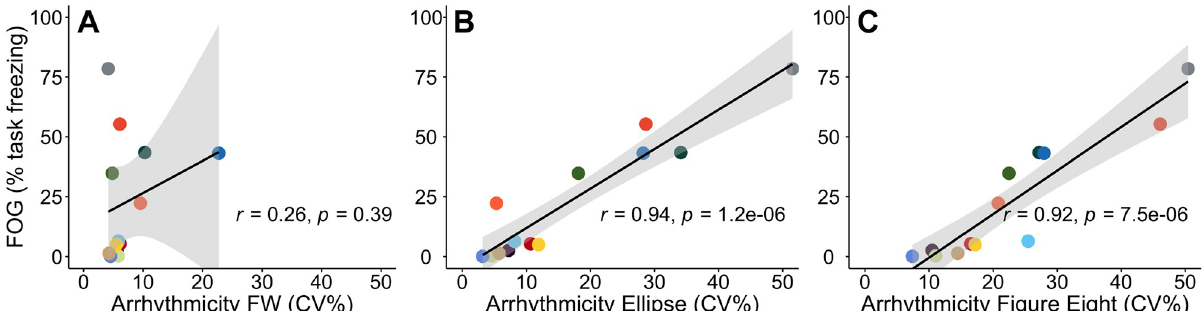
Fig 6. Relationship between freezers’ non-freezing gait arrhythmicity and freezing severity. Relationship between freezers’ non-freezing gait arrhythmicity and percent time freezing A: during FW, B: during the TBC ellipses, and C: during the TBC figures of eight. Regression lines (black line) and confidence intervals of the correlation coefficient at 95% (shaded grey), and subjects (colored dots) shown.